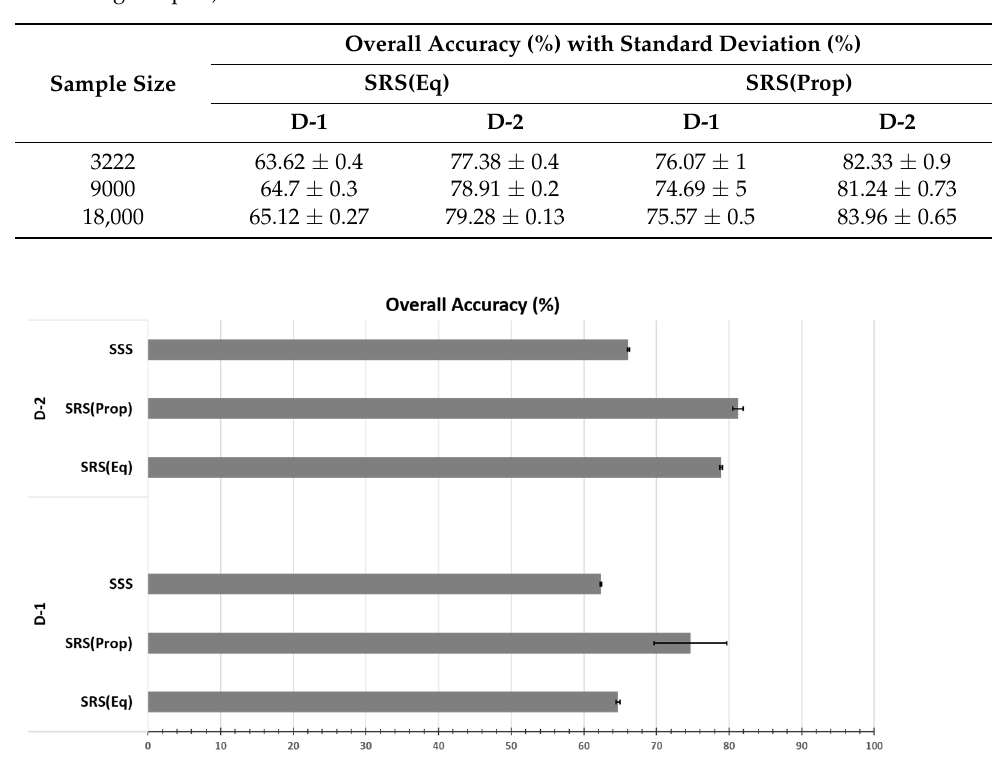
Table 4. Average overall accuracy and standard deviation of Random Forest (RF) classified land cover map obtained for D-1 and D-2 datasets using Stratified Equal Random Sampling (SRS(Eq)) and Stratified Proportional Random Sampling (SRS(prop)) methods with different sample size (training and testing samples) for 100 trials.